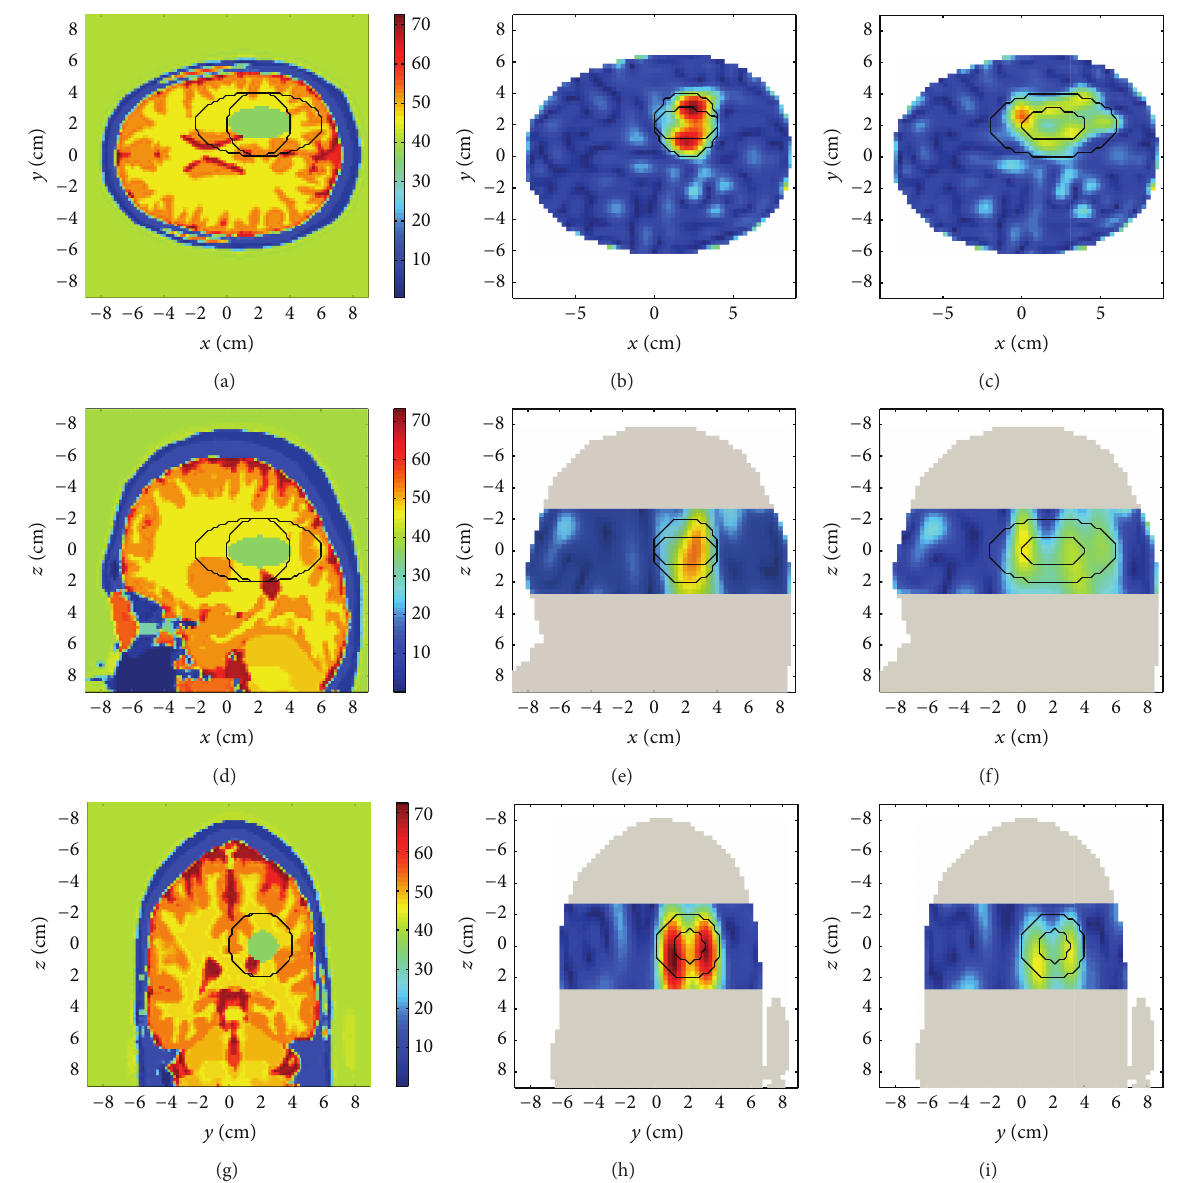
Figure 7: 3D validation of the followup of a postdiagnosis evolution of an ischemic brain stroke via the proposed differential TSVD imaging approach. (a) Scenario at the time 𝑇 0 (stroke diagnosis) with black contours referring to the stroke’s position at times 𝑇 1 and 𝑇 2 ( 𝑥 − 𝑦 slice cutting the center of the stroke); (b) reconstruction at time 𝑇 1 : slice cutting the center of the stroke in the 𝑥 − 𝑦 plane; (c) as (a) at time 𝑇 2 ; (d) reconstruction at time 𝑇 1 : slice cutting the center of the stroke in the 𝑦 − 𝑧 plane; (e) as (c) at time 𝑇 2 ; (f) reconstruction at time 𝑇 1 : slice cutting the center of the stroke in the 𝑥 − 𝑧 plane; (g) as (f) at time 𝑇 2 . A gaussian noise with SNR = 70 dB has been assumed and a simplified homogeneous reference head model is